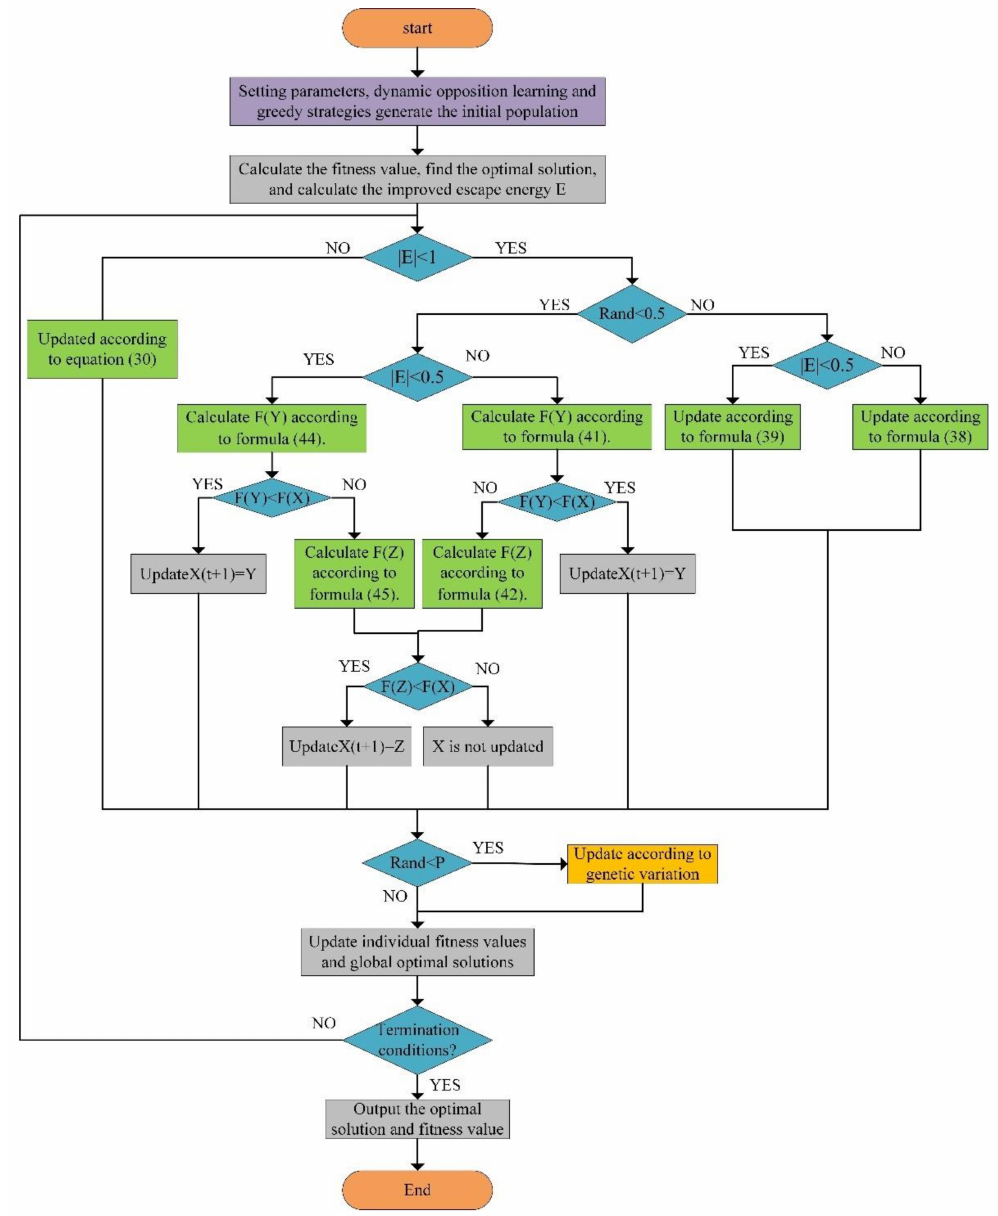
Figure 6. Improved flow chart for Harris Hawk